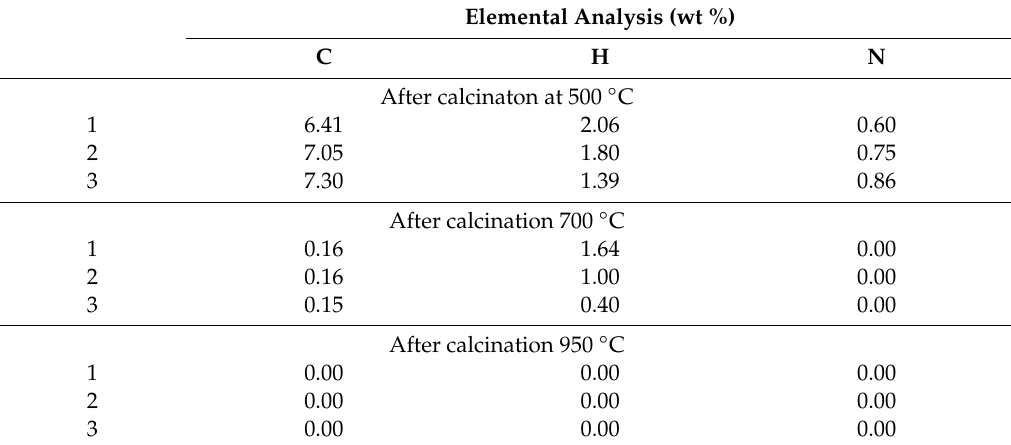
Table 6. Elemental analysis of regenerated catalyst (non-treated) at 500, 700 and 950 ◦